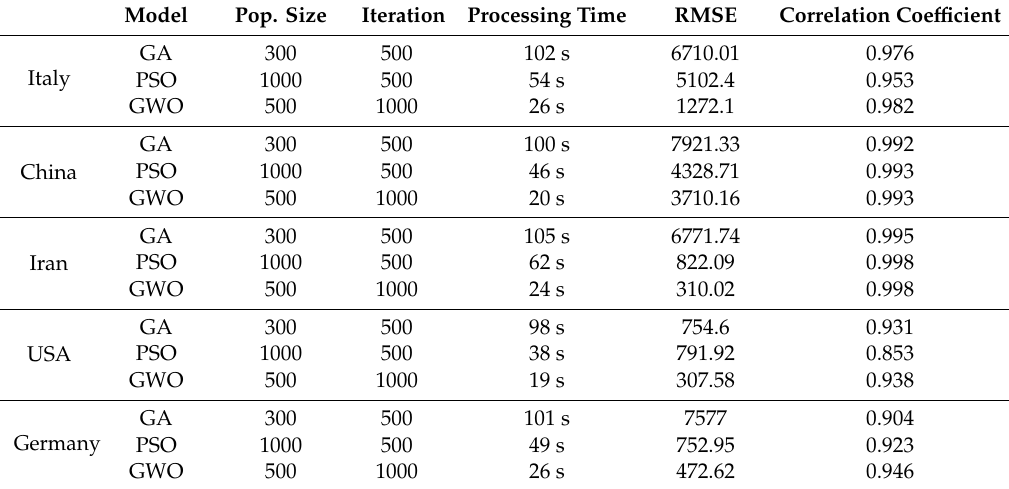
Table 6. Accuracy statistics for the quadratic model.